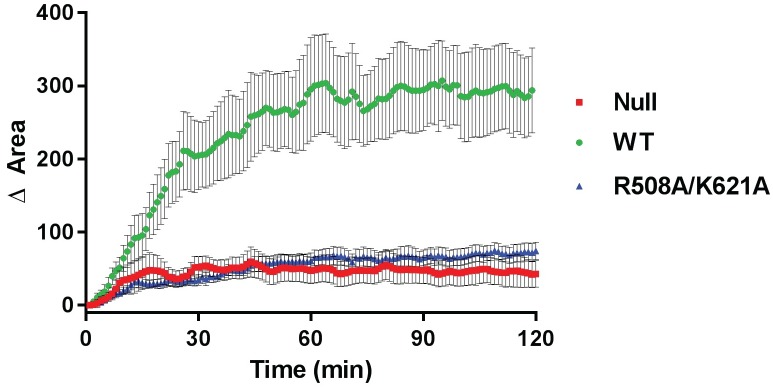
The R508A/K621A mutant is defective at promoting cell spreading.fak-/- cells and fak-/- cells expressing wild type FAK or the R508A/K621A mutant were transfected with GFP-paxillin as a fluorescent marker for time lapse imaging. Cells were trypsinized, taken into suspension and plated on fibronectin coated imaging dishes. After 5 minute incubation to allow for attachment image acquisition was initiated. Images were captured every minute for 120 minutes and cell diameters were determined using Nikon NIS Elements analysis software. The change in average cell area (+/- S.D.) for each cell type is plotted against time following initiation of imaging. (n = 18–20 cells over 4 experiments)